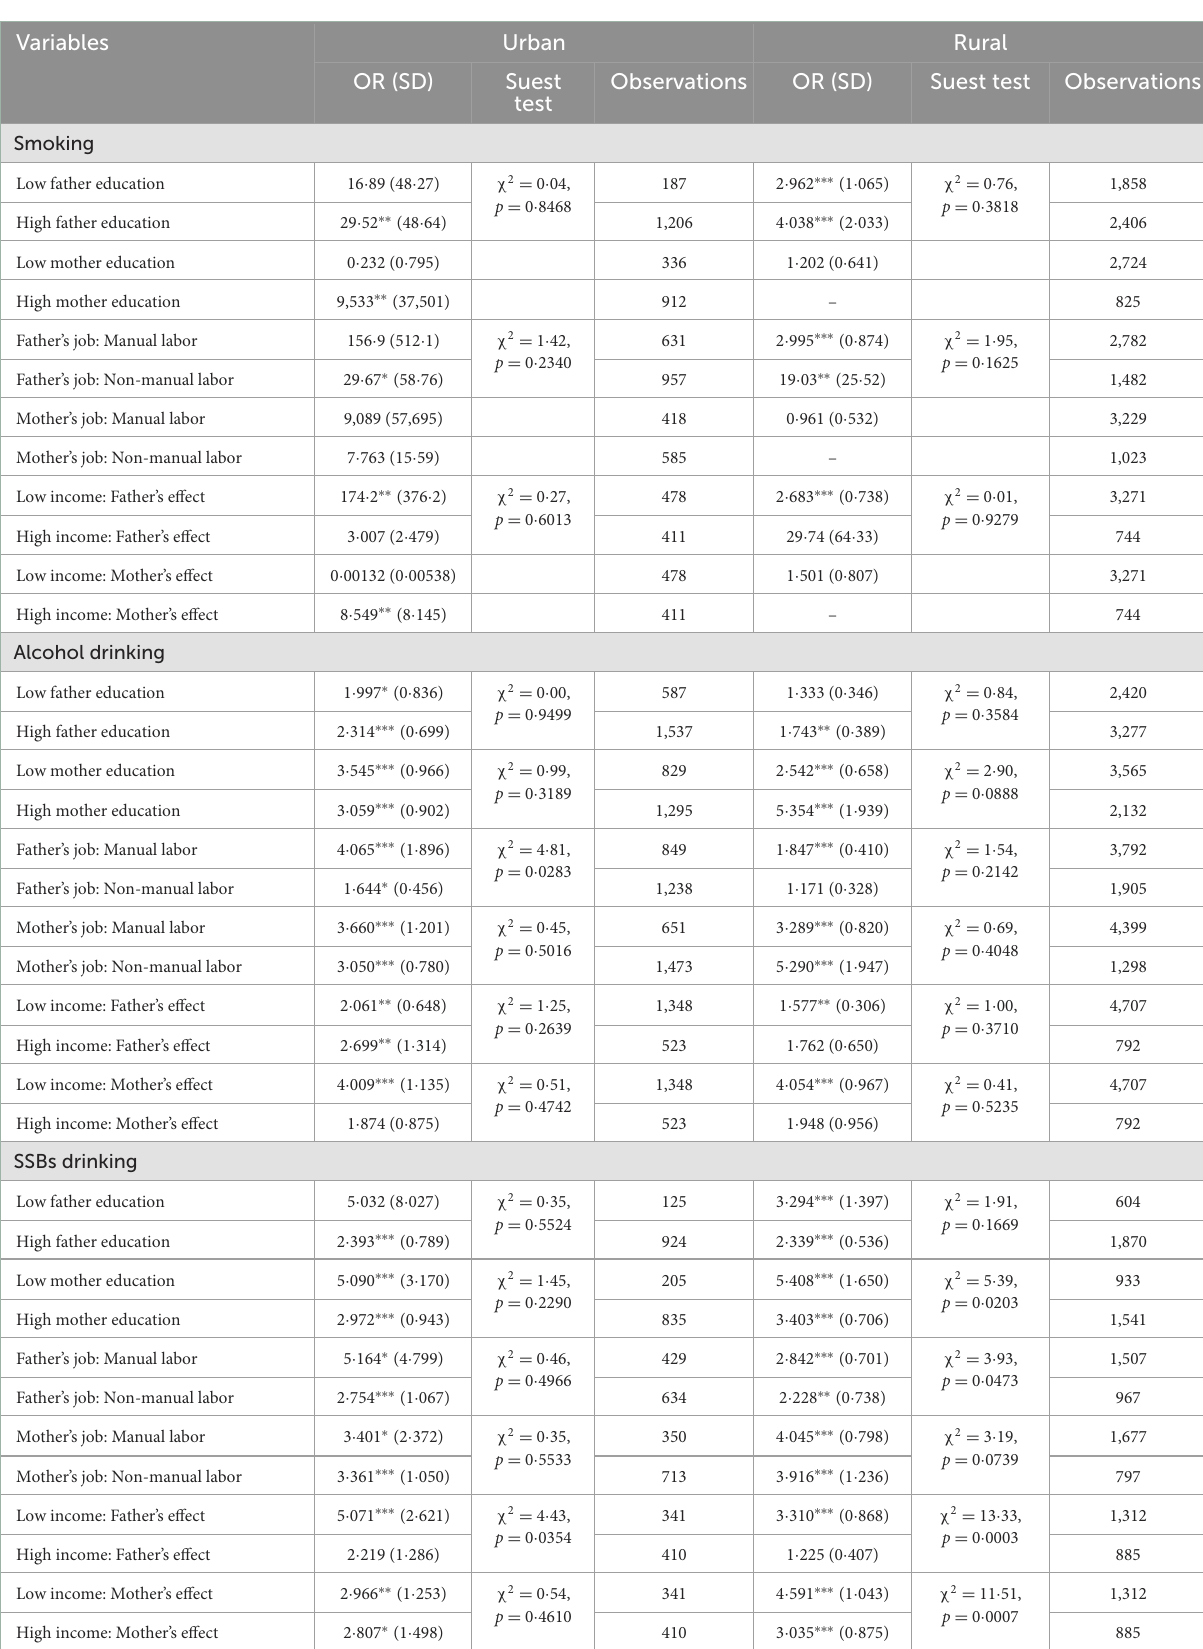
TABLE 3 Subgroup analysis of intergenerational transmission with different SES. Variables Urban Rural OR (SD) Suest Observations OR (SD) Suest test test